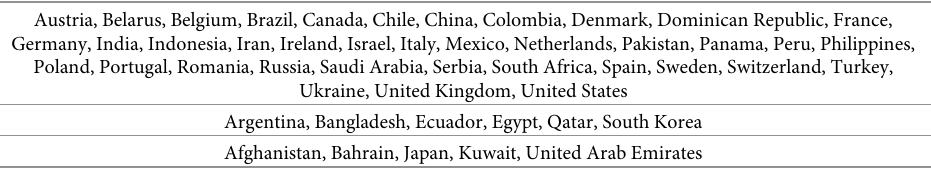
Table 6. Countries rhythms classification by means of a Machine